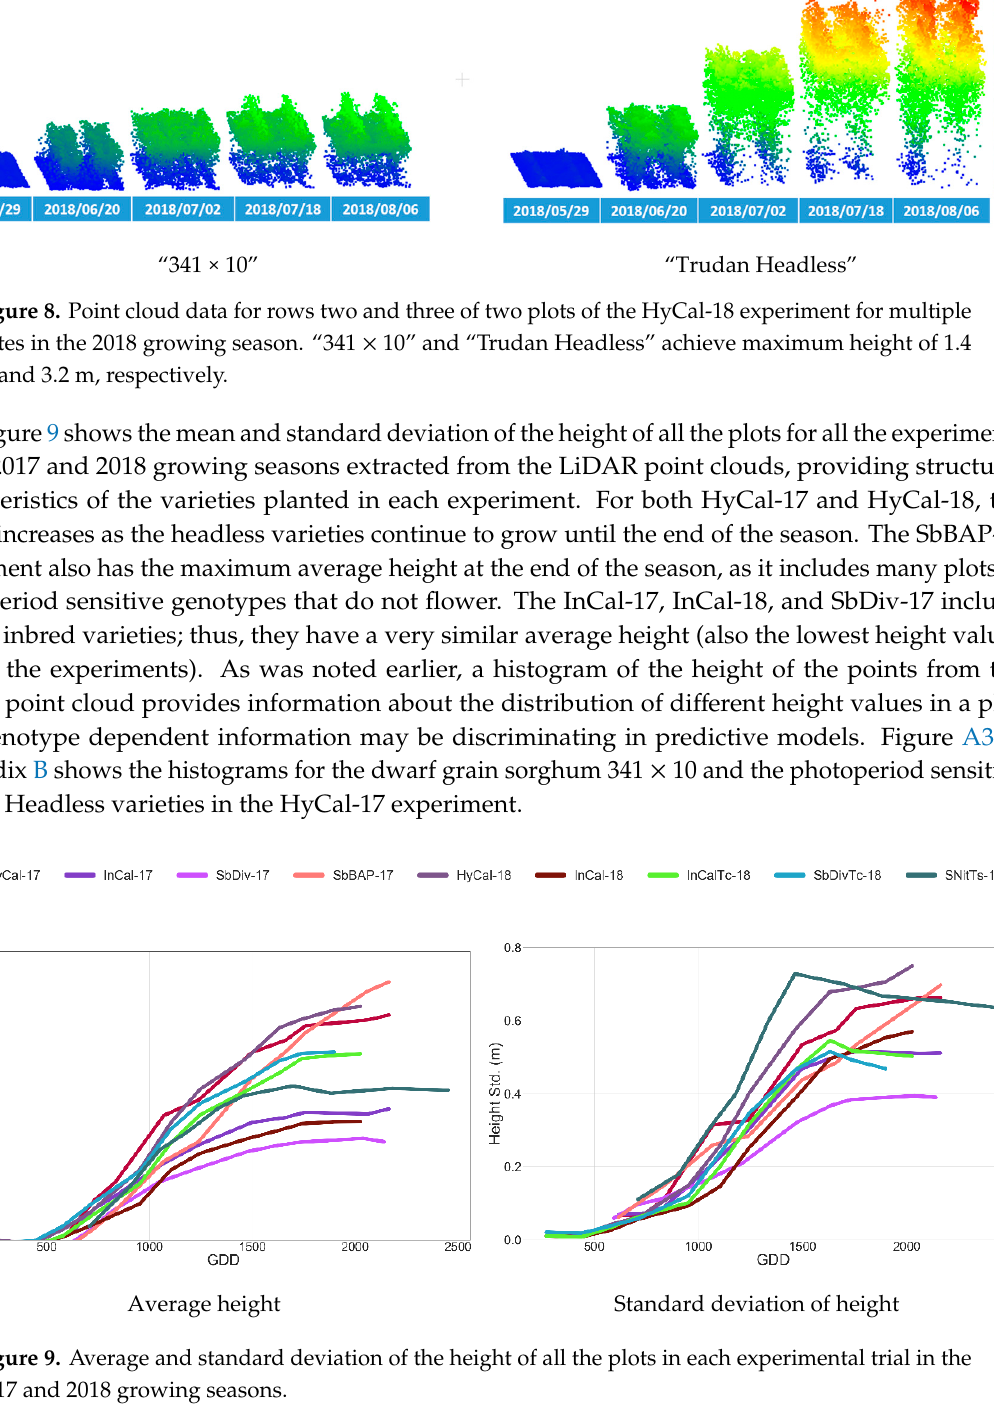
Figure 8. Point cloud data for rows two and three of two plots of the HyCal-18 experiment for multiple dates in the 2018 growing season. “341 × 10” and “Trudan Headless” achieve maximum height of 1.4 m and 3.2 m, respectively.